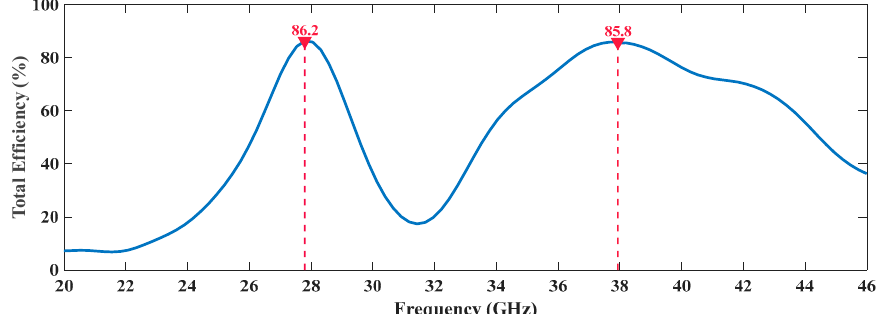
Figure 9. Efficiency Variation Over Frequency of the Dual-Band Antenna.